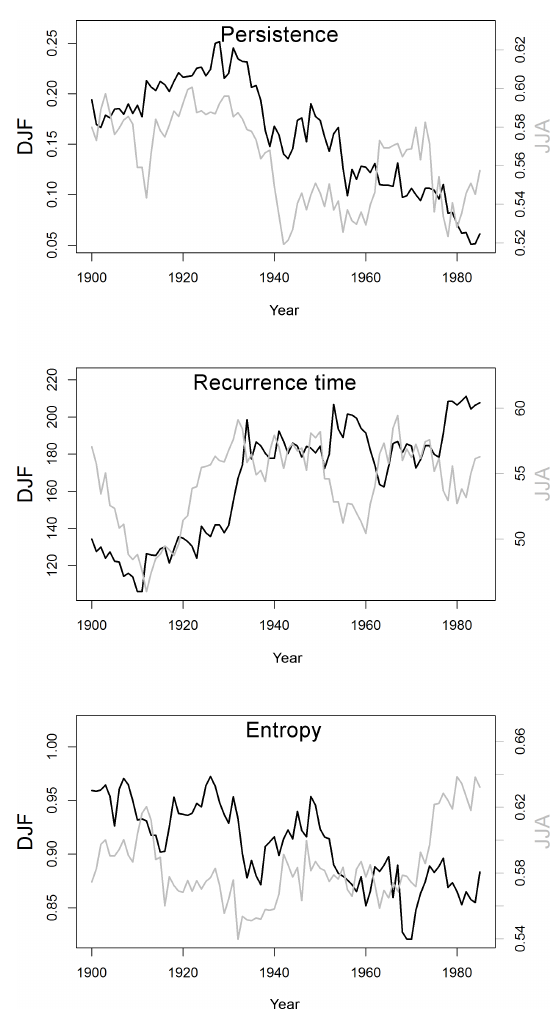
Figure 3. Descriptors for ECA&D station data for running windows over 30 years (values are assigned to the first year of the 30-year time period) from 1900 to 2015. Black curve: cold and wet extremes in winter (DJF) (Ta < 10th percentile and Pa > 75th percentile). Gray lines: hot and dry extremes in summer (JJA) (Ta > 90th per- centile and EDI < 25th